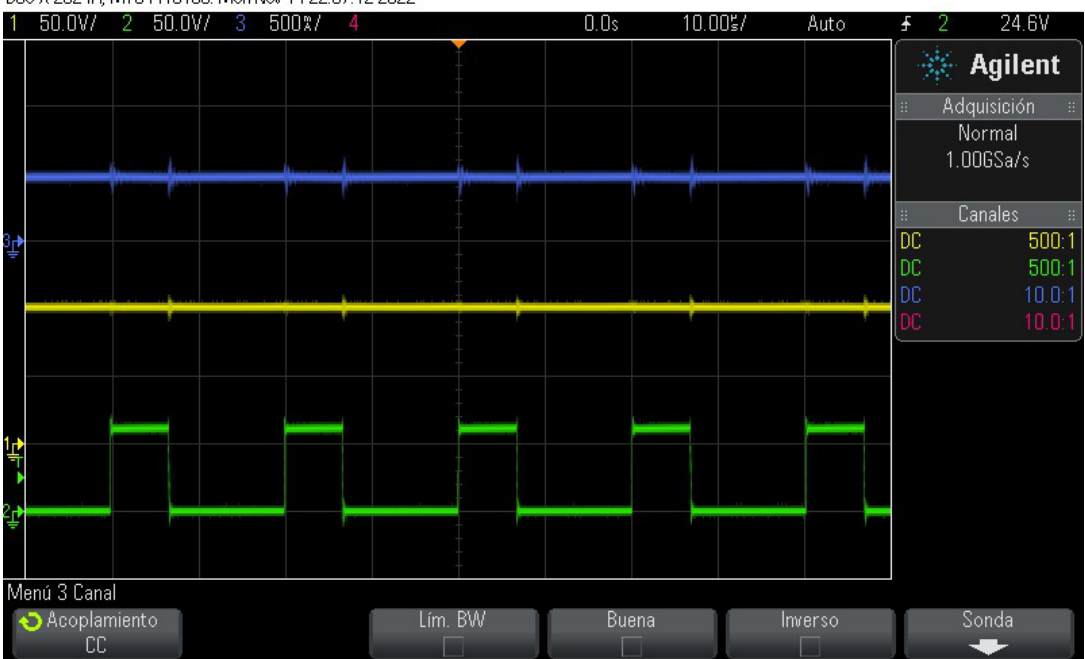
Figure 16. From the top to the bottom: output current I o (blue trace), output voltage V o (yellow trace), and terminal voltage of transistor ¯ s 1 = 60 V (green trace) of DDSB.